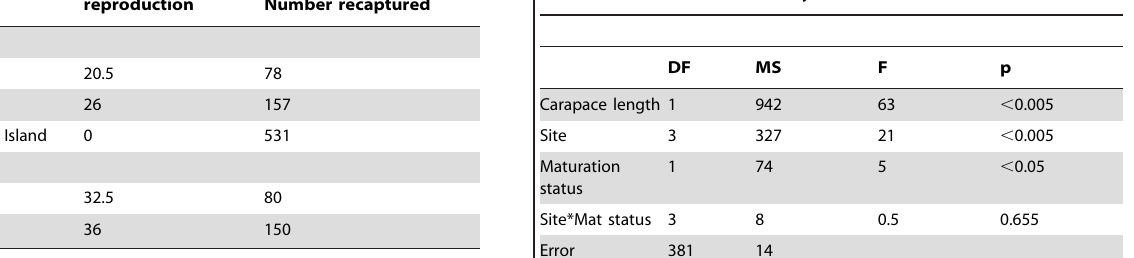
Table 2. Summary of ANCOVA of J. edwardsii growth at sites of translocation in the first year after